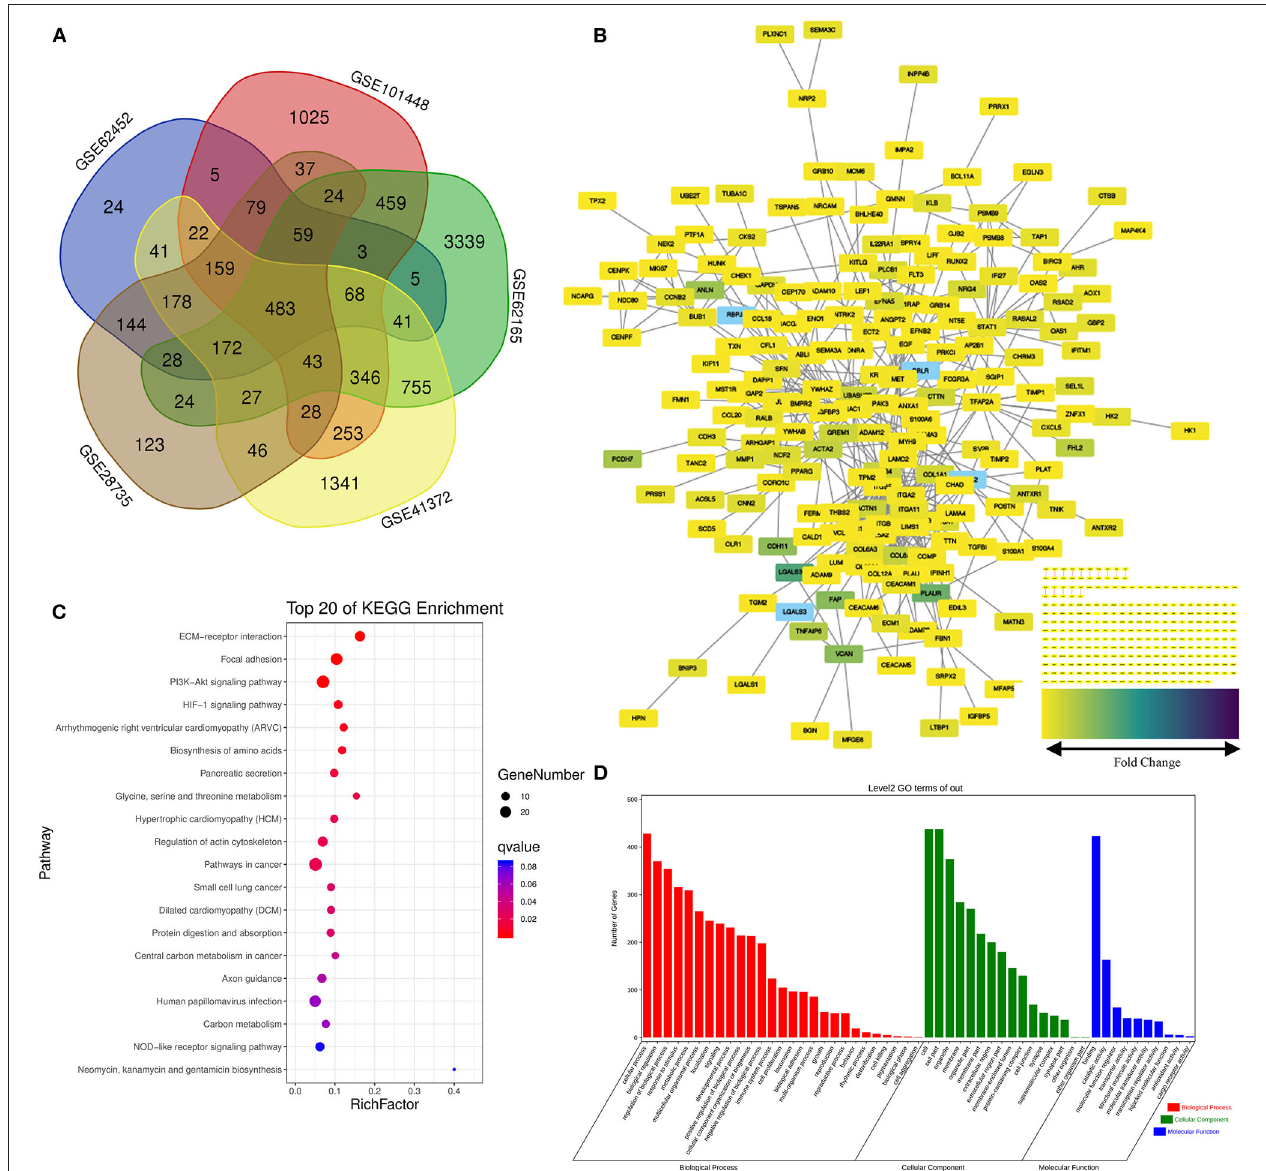
FIGURE 2 | Screening of the differentially expressed genes (DEGs) in the pancreatic cancer establishment of the functional interaction (FI) network. (A) A flower-shaped Venn diagram showing 483 DEGs between pancreatic cancer and normal pancreatic tissues among five studies. (B) The FI network was established using pancreatic cancer-related 483 DEGs. Edges were based upon the FI annotation. Node colors defined fold changes in pancreatic cancer-related DEGs, ranging from yellow for low expression to purple for high expression, compared to non-cancerous samples. (C,D) Gene functional enrichment of the 483 DEGs. Kyoto Encyclopedia of Genes and Genomes (KEGG) showed the top 20 signaling pathways, and Gene Ontology (GO) analysis showed the biological processes and molecular functions involved in differential genes.